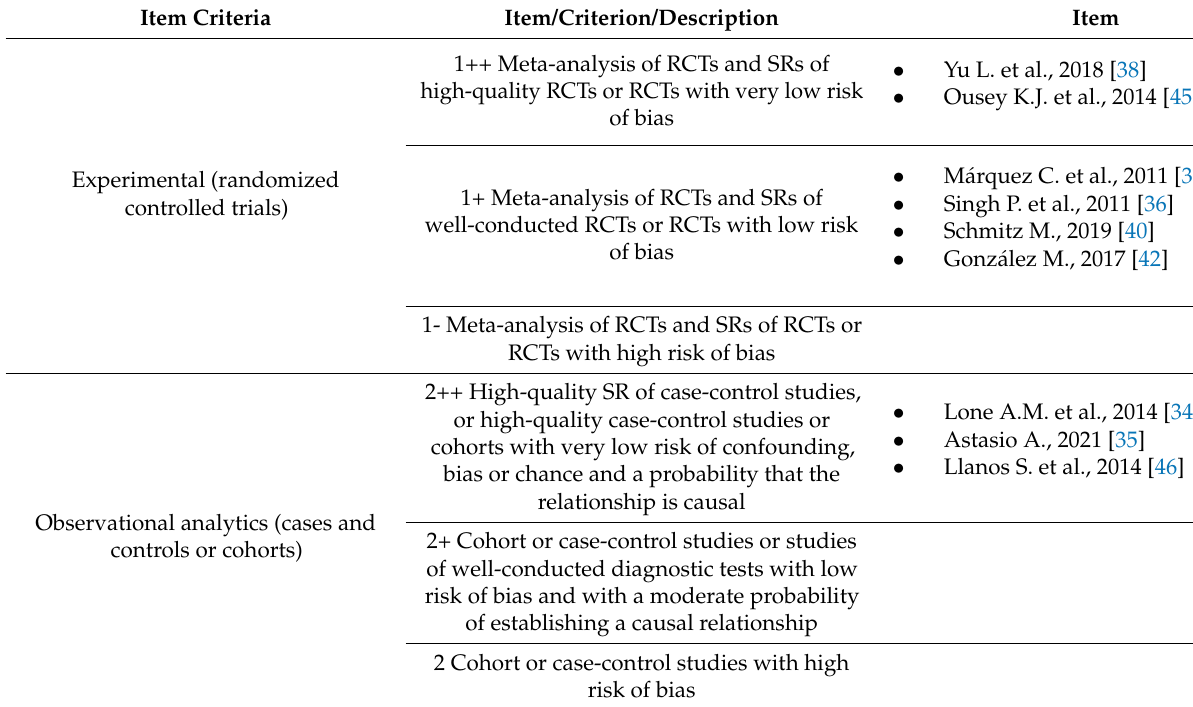
Table A2. Scottish Intercollegiate Guidelines Network